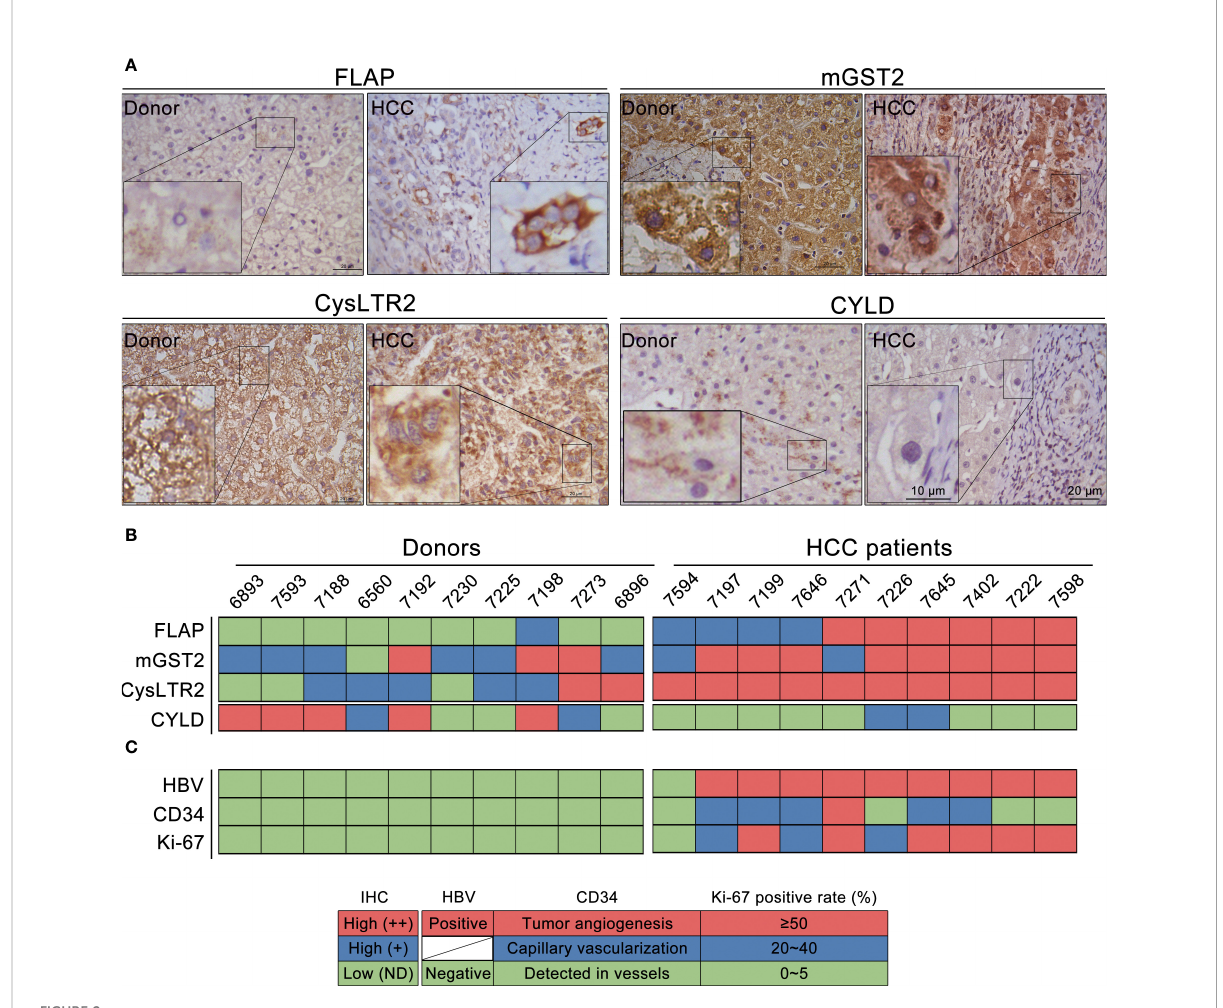
FIGURE 2 Overexpression of FLAP correlates to CYLD suppression in resection tissues of HCC patients. (A) Representative immunohistochemistry (IHC) images of FLAP, MGST2, CysLTR2, and CYLD in each subject using the indicated antibodies. Scale bar = 20 m m, bar = 10 m m (magni fi cation). (B) The expression levels of FLAP, mGST2, CysLTR2, and CYLD were clustered. Patient and donor codes are indicated. Grades of the indicated markers (Red: ++ = brown, Blue: + = golden, Green: ND = not detected). (C) The expression levels of CD34 localization and positive rate (%) for Ki-67 were clustered. Patient and donor codes are matched with each other. For each analysis, n = 10/per